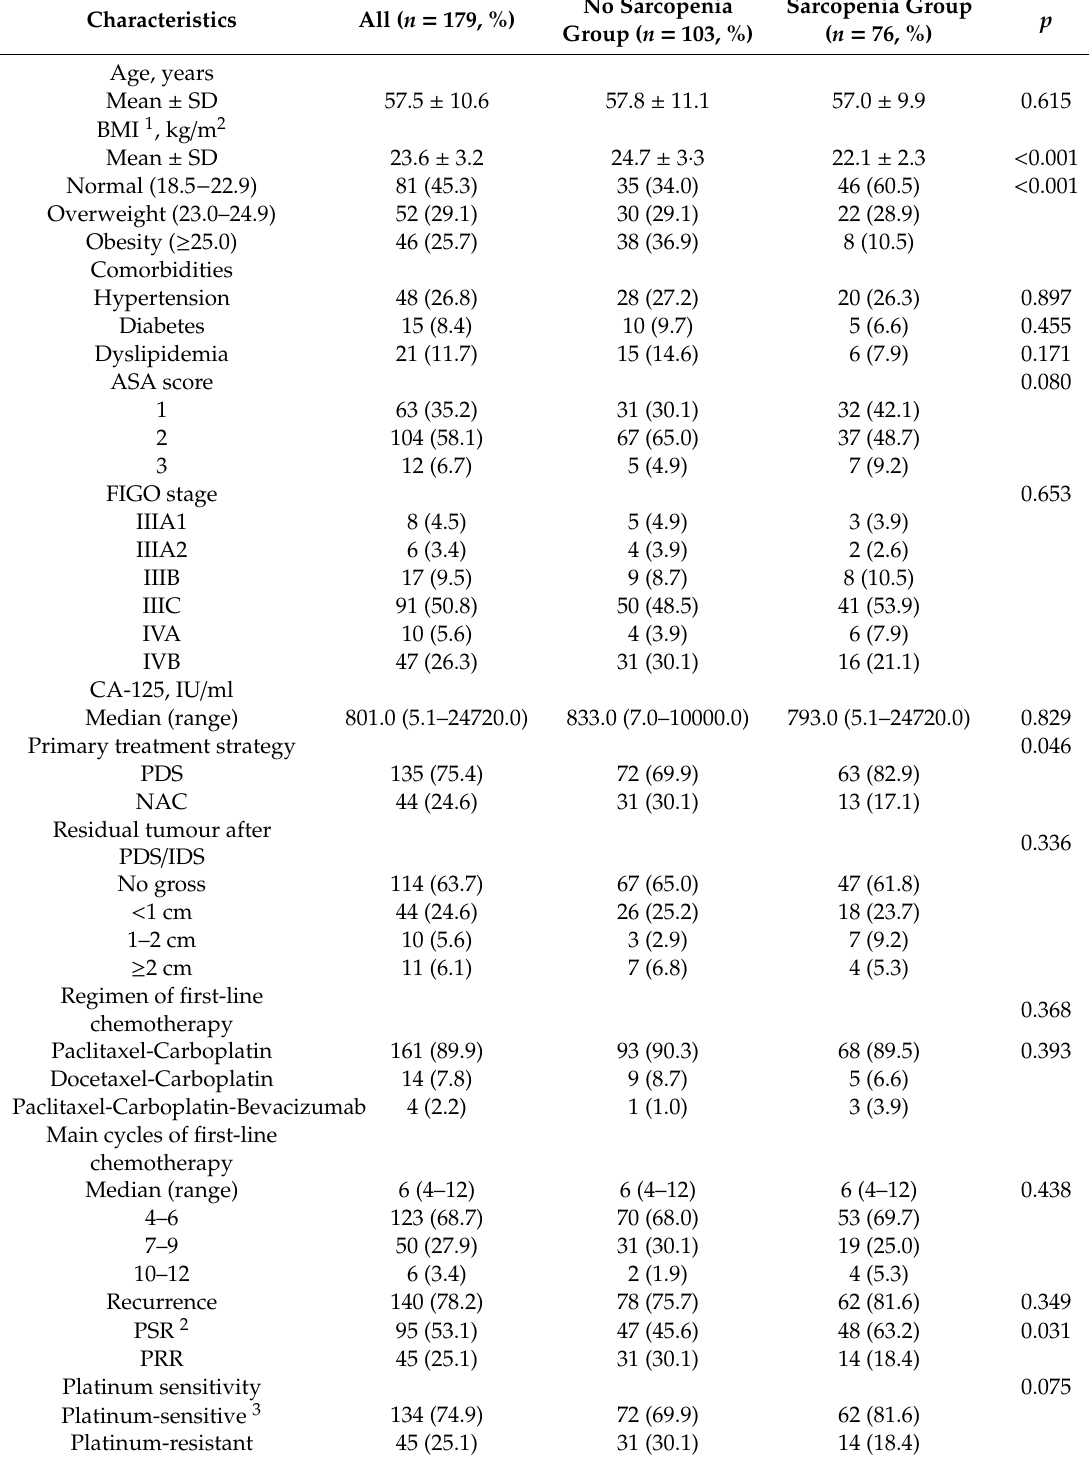
Table 1. Clinicopathologic characteristics of all